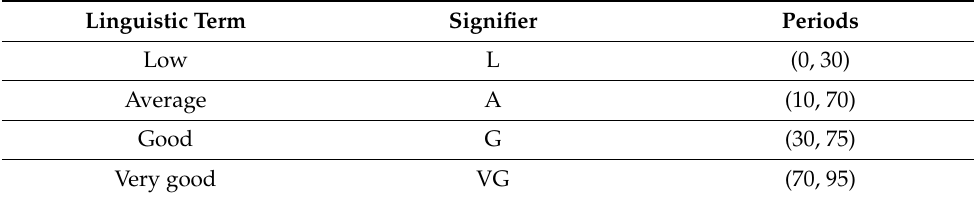
Table 3. Fuzzy set of input knowledge.